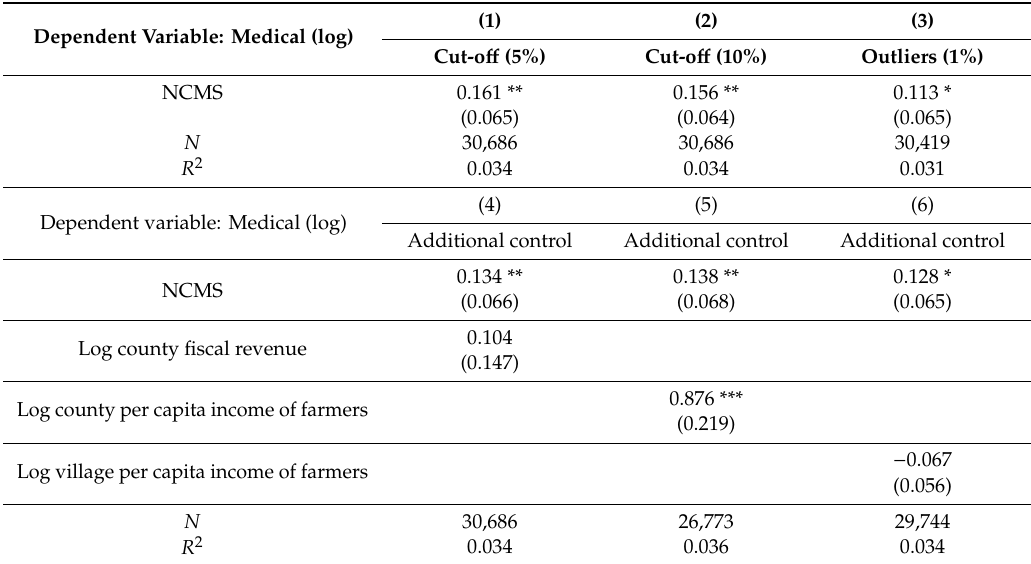
Table 5. Robustness Checks.